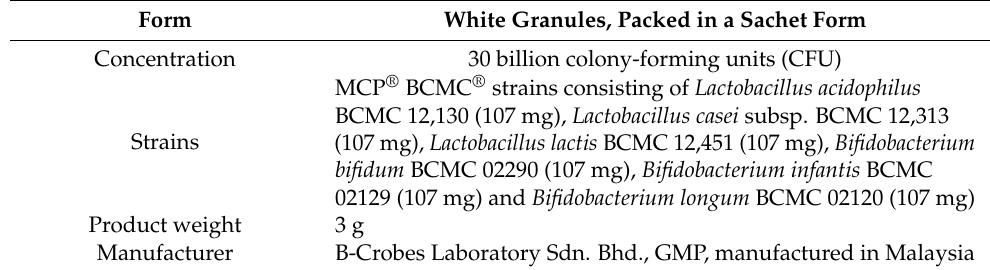
Table 1. Contents of the probiotics used in the study. Form White Granules, Packed in a Sachet Form Concentration 30 billion colony-forming units